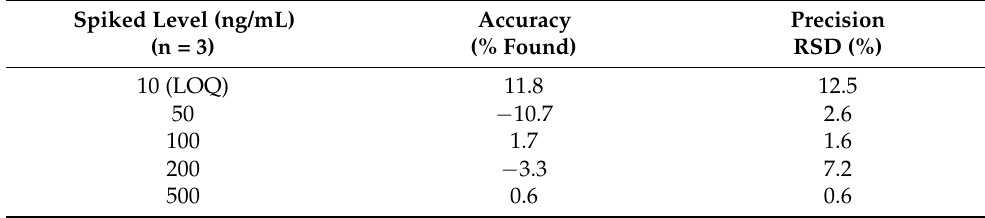
Table 5. Accuracy and precision data for of naftazone determination in spiked serum